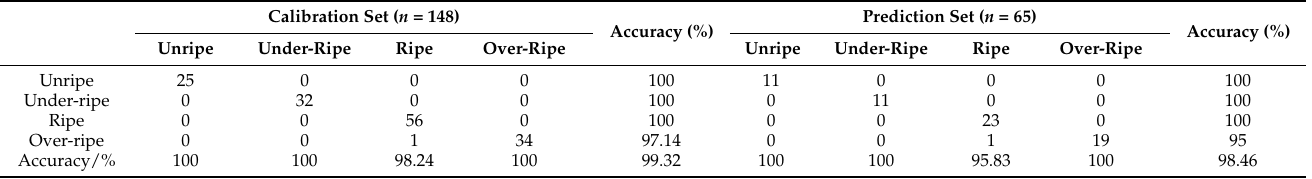
Table 5. Confusion matrices of tobacco leaves with various maturities obtained using SNV-SPA-PLS-DA. Calibration Set ( n = 148) Prediction Set ( n = Accuracy (%)